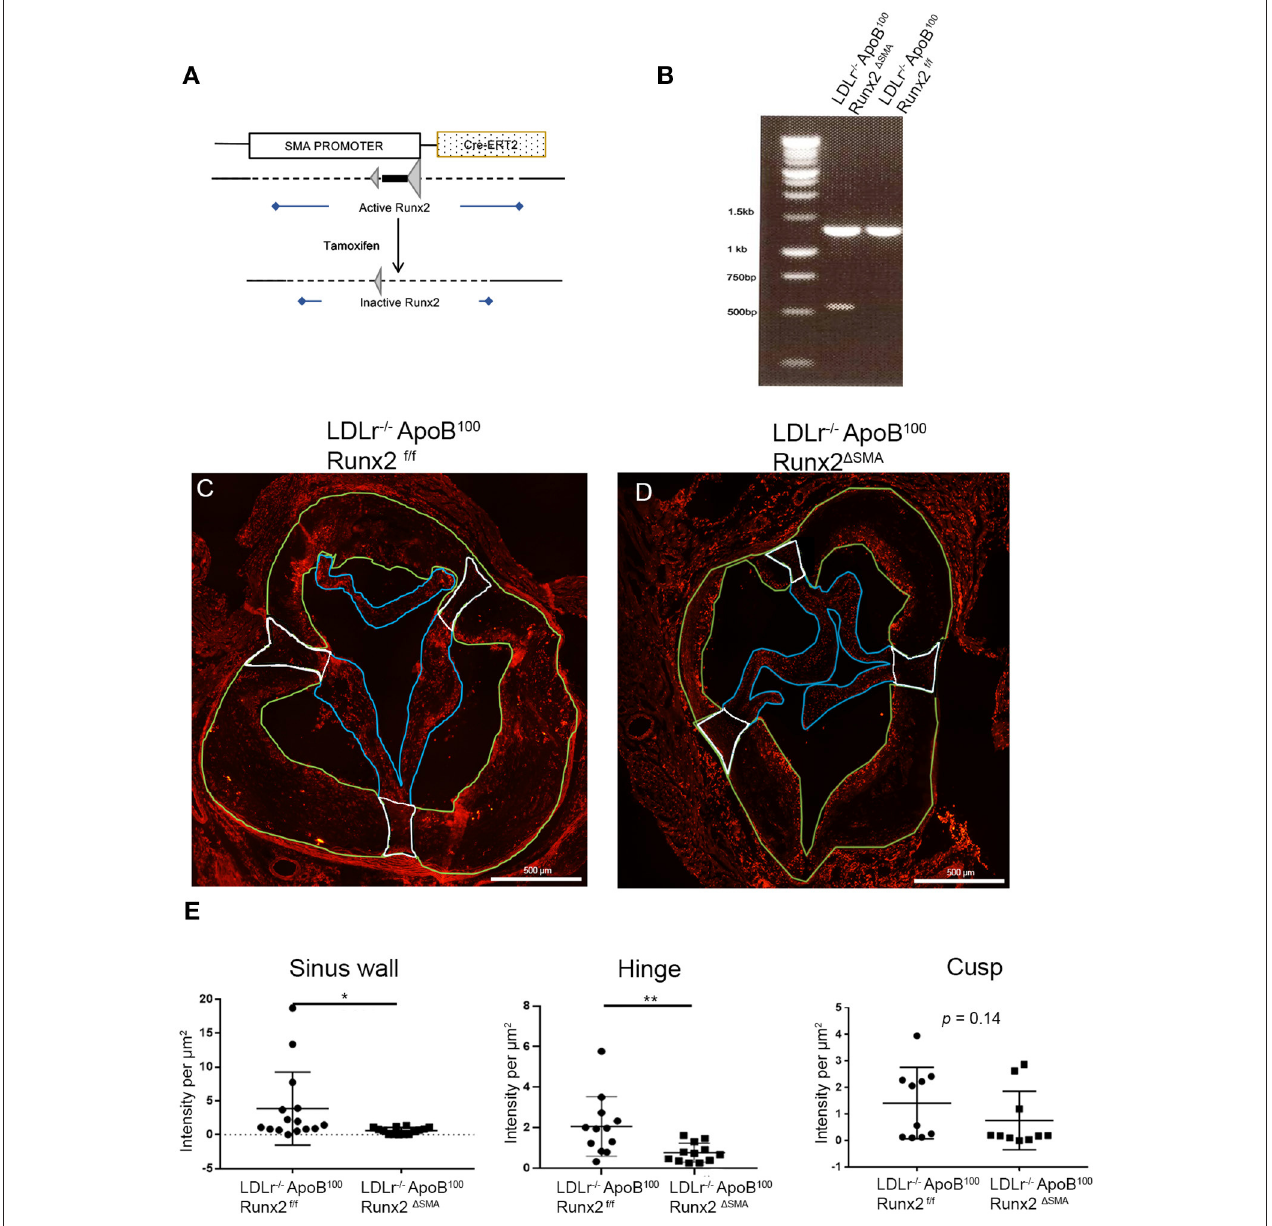
FIGURE 4 | Runx2 depletion in the aortic valve. (A) Schematic tamoxifen-induced Cre recombination that leads to a temporal inactivation of Runx2 in SMA + VICs and sinus valve cells. (B) PCR genotyping to amplify the loxP flanked sites to confirm Runx2 depletion in the aortic valve. IF of aortic valve sections from LDLr − / − ApoB 100 Runx2 f / f (C) and LDLr − / − ApoB 100 Runx2 1 SMA (D) mice for Runx2. Green borders highlight the sinus wall region, white borders highlight the hinge region and blue borders highlight the cusp region. (E) Quantification of Runx2 intensity in valve sections in the sinus wall, hinge, and cusp regions ( n = 15 per group). Differences between groups were analyzed by Mann-Whitney non-parametric tests. * p < 0.05, ** p < 0.005. Data shown are mean ± SD, n = 15.